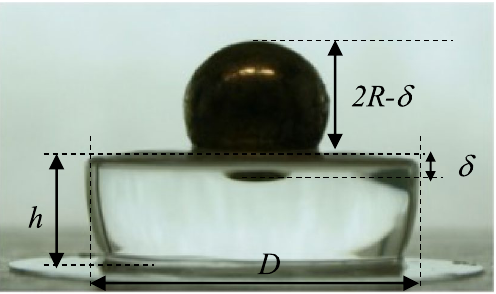
Figure 12. Example of image analysis for the determination of parameters δ, h, D with a MATLAB